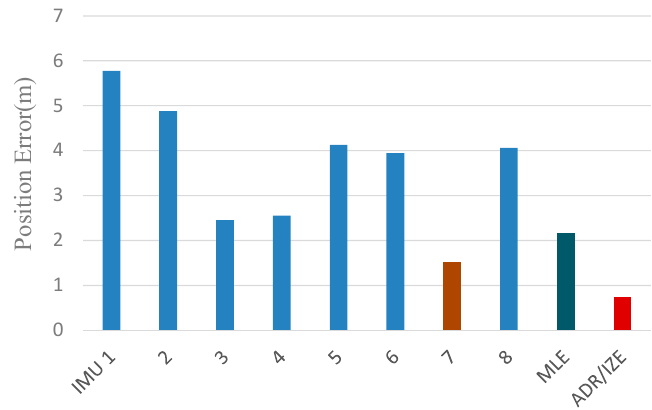
Figure 13. Positioning results of eight IMUs on the array in one closed-loop experiment.